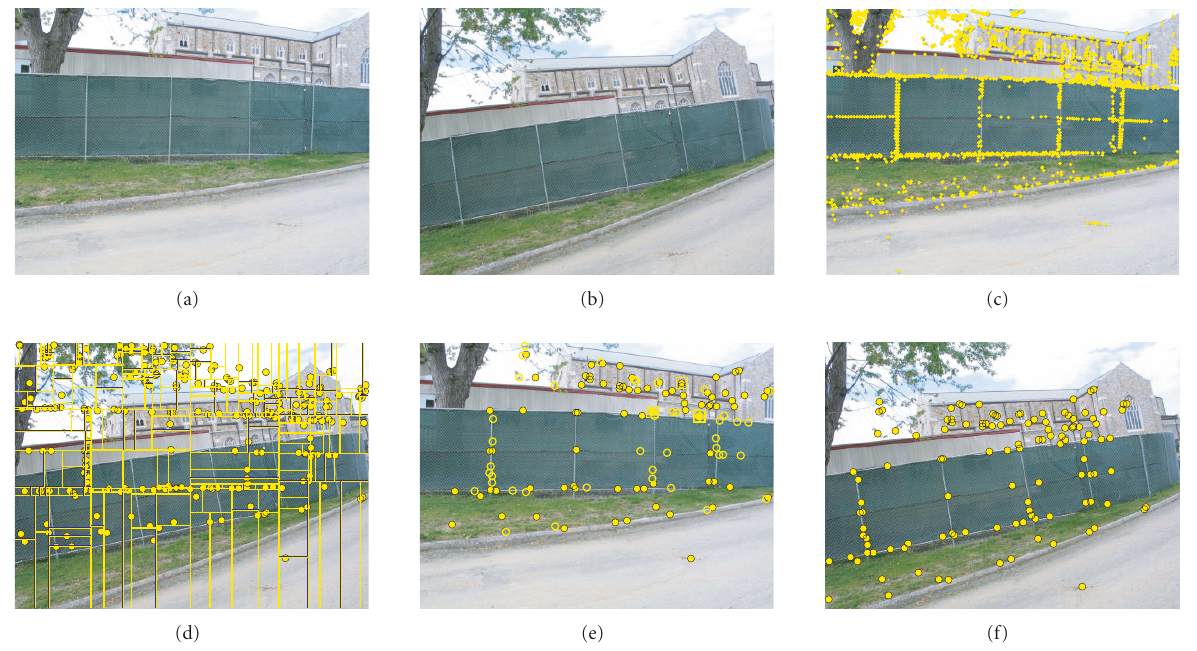
Figure 3: Example results of image matching from a pair of images. (a) Image 1. (b) Image 2. (c) The 1976 detected features in image 1. (d) The k-d tree and corresponding 256-feature digest in image 1. (e) The dots indicate 78 features in image 1 detected as correspondences in image 2, using the minimal Euclidean distance between SIFT descriptors and the ratio criterion with a threshold of 0 . 6. The 3 squares indicate outlier features that were rejected. The circles indicate 45 new correspondences that were grown based on the epipolar geometry, for a total of 120 correspondences. (f) The positions of the 120 corresponding features in image